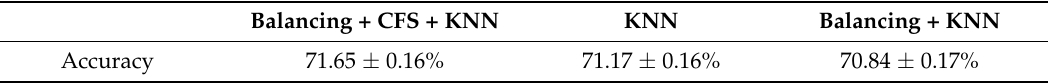
Table 5. Feature selection method on engagement recognition.